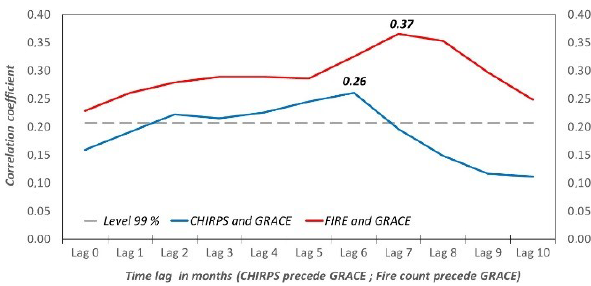
Figure 4. Synchronous linear correlation (lag 0) and up to an 10- month time lag between CHIRPS precipitation and WEH GRACE monthly variations on the 2002–2016 period (in blue) and between fire count and WEH GRACE (in red); the 99% significance level is indicated by a dashed